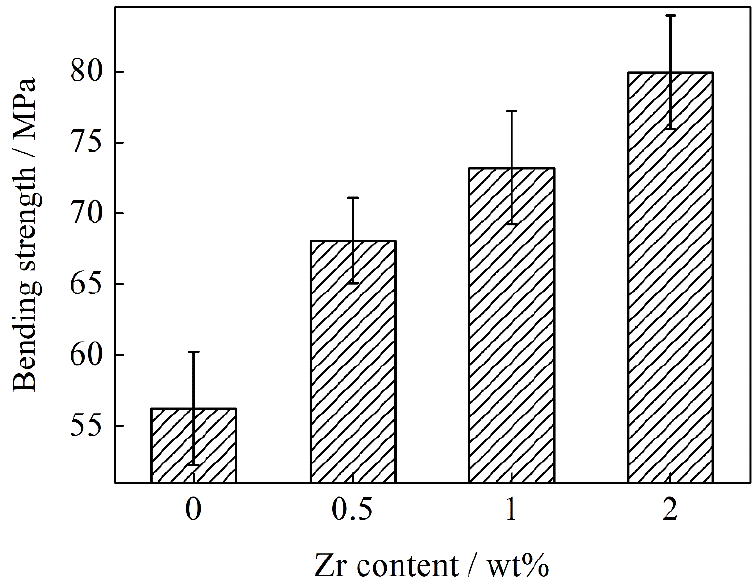
Figure 12. Bending strength of FG/Cu composites with different Zr contents.